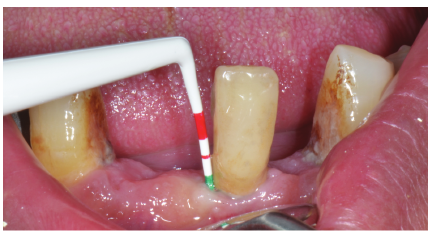
Figure 7: Clinical investigation is performed by periodontal probe in order to evaluate the socket